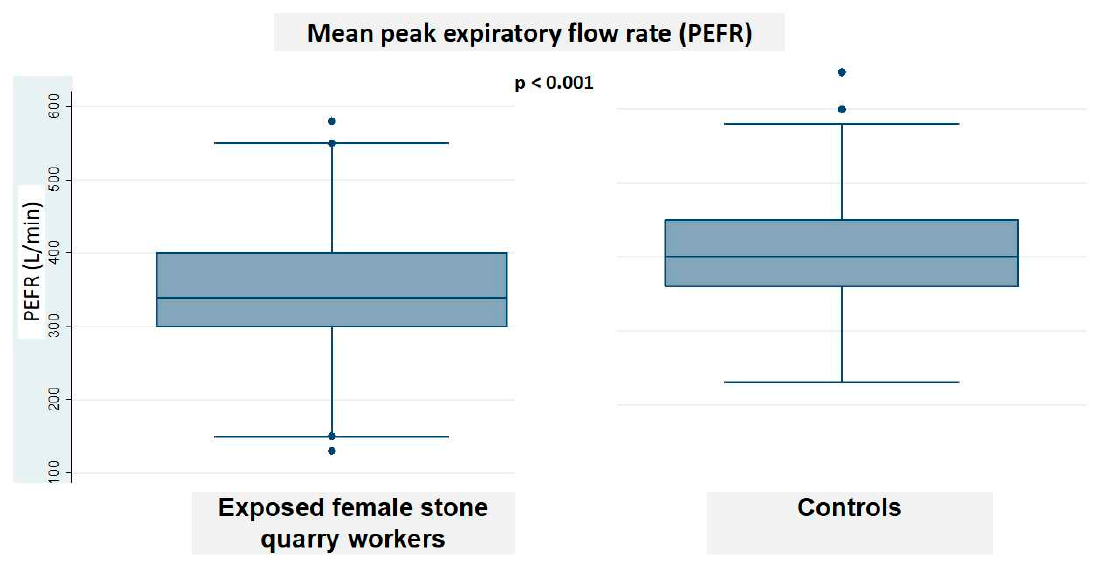
Figure 3. Box plot image showing the distribution of mean PEFR values in exposed women stone quarry workers and controls.